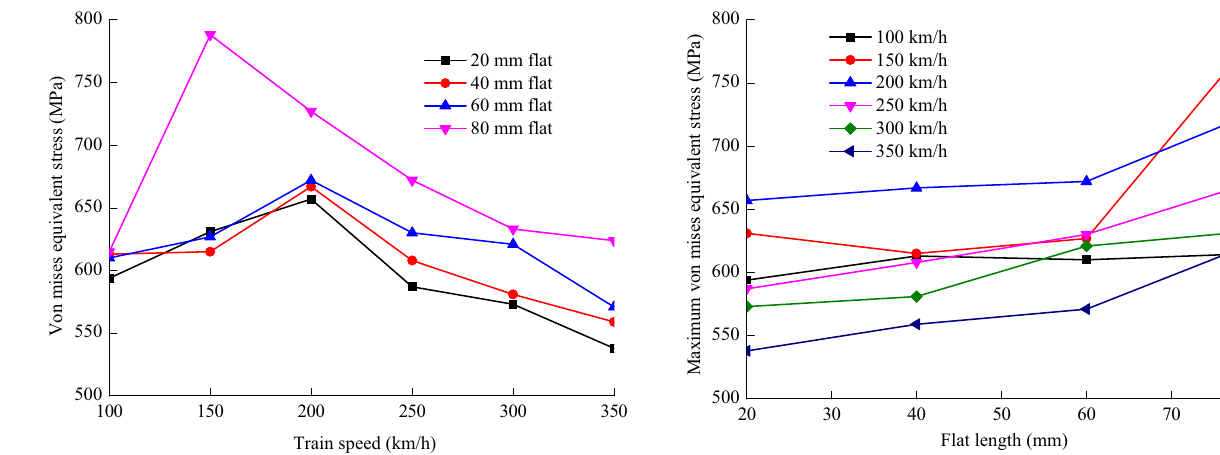
Fig. 7 Maximum von Mises equivalent stress as a function of train speed